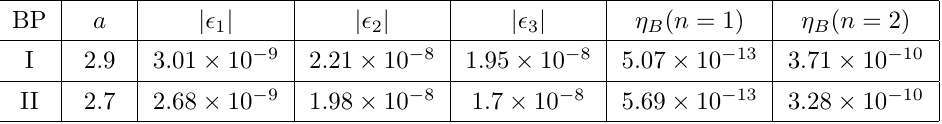
Table 4 . Estimating baryon asymmetry considering compressed mass hierarchy with M φ { 10 7 , 10 7 . 1 , 10 7 . 2 } GeV for the two benchmark points in table 2.